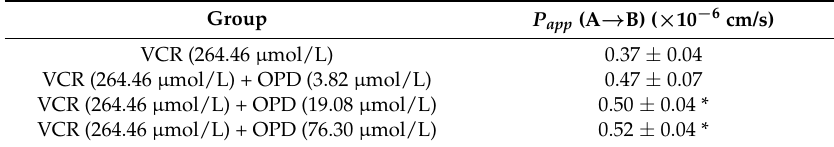
Table 2. Effects of OPD on transport of VCR in MDCK-MDR1 cell monolayers ( x ± s , n = 3).